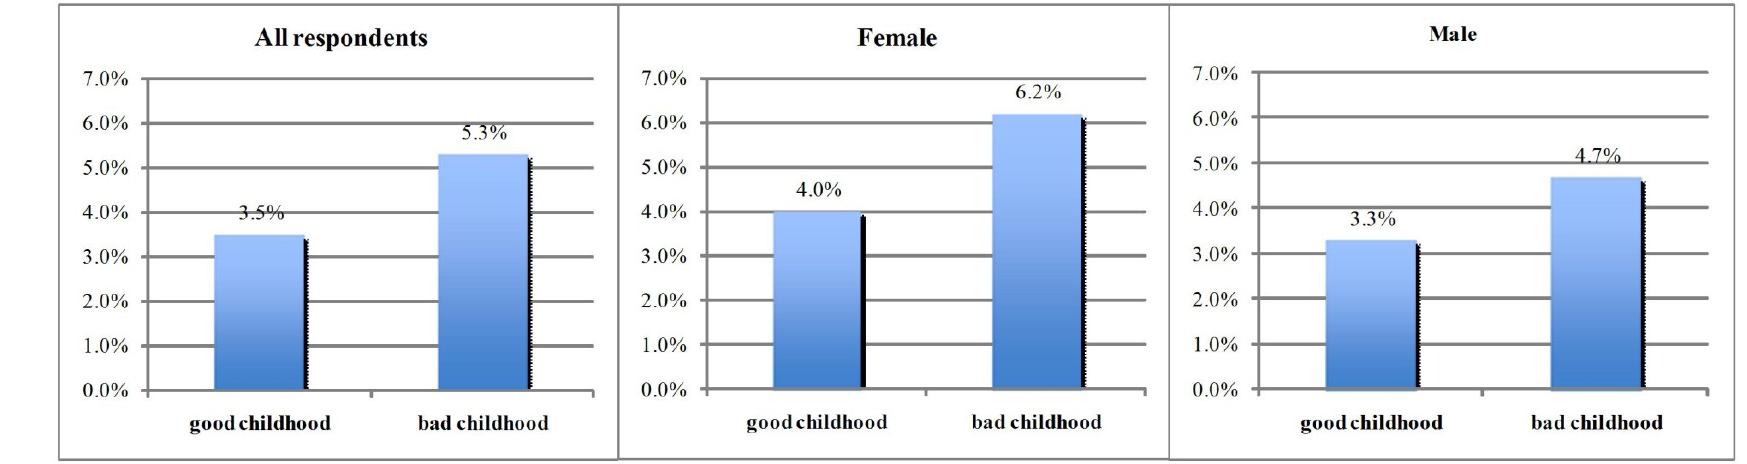
Figure 1. The morbidity of CVDs by childhood health.